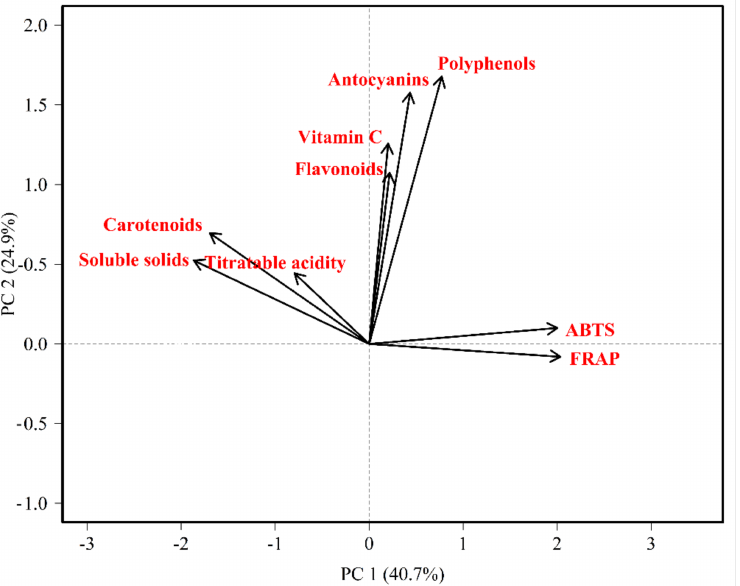
Figure 2. Principal component analysis for chemical fruit traits in a tree tomato breeding